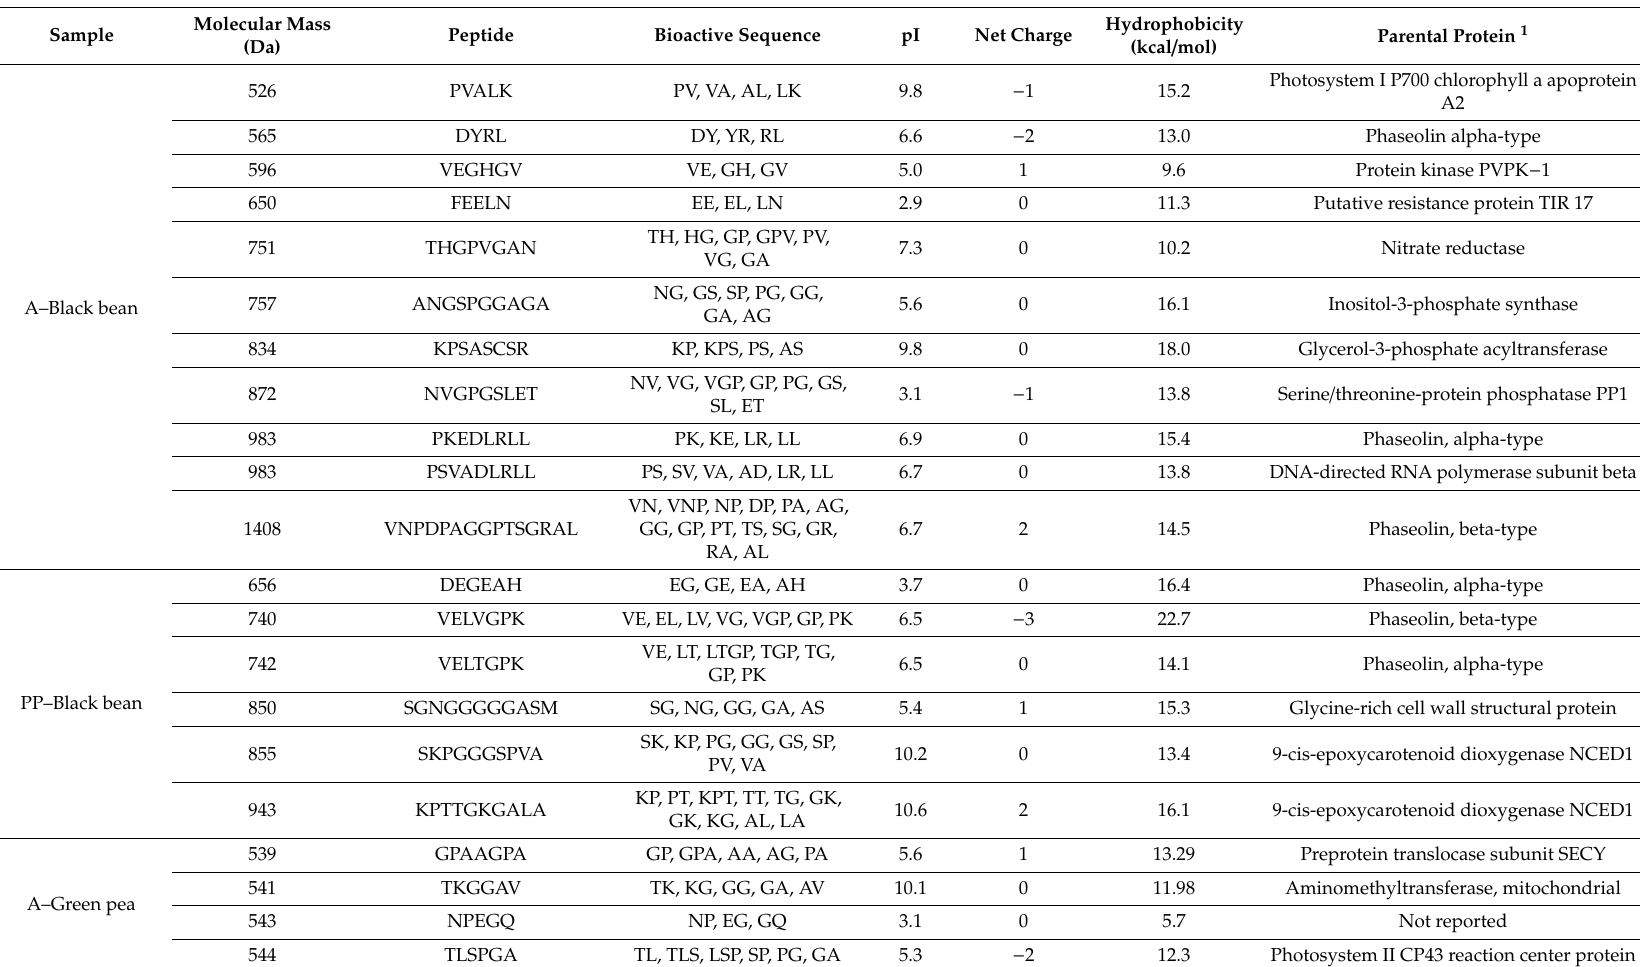
Table 1. Physicochemical properties and their origin protein of the peptides obtained from the legume protein hydrolysates